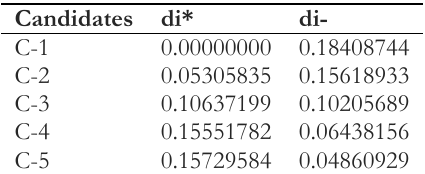
Table 12. The results of distances from the best alternative (di*) and the worst alternative (di-) for the